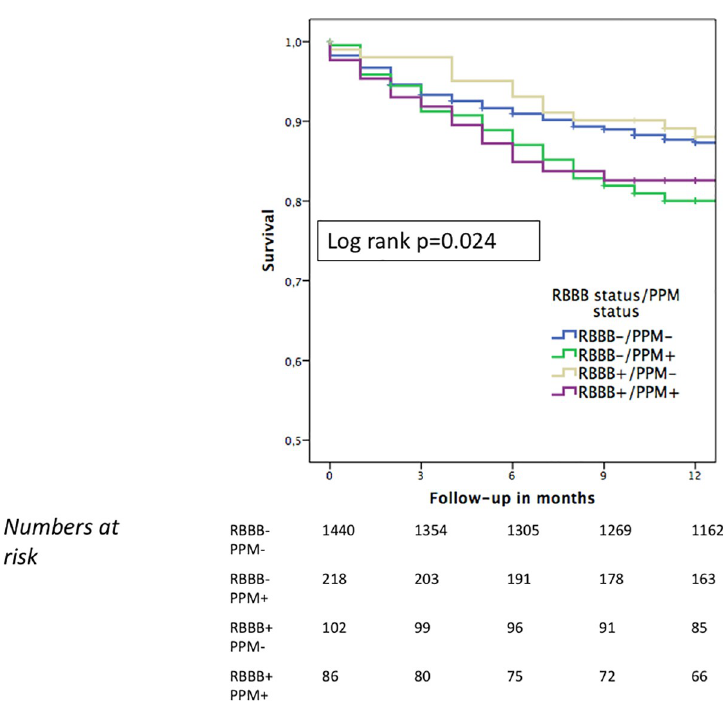
Fig 2. Kaplan-Meier estimates for one-year survival in RBBB versus non-RBBB patients stratified according to PPM implantation. During a follow-up time of 12 months, there was a significant difference in survival probability between the subgroups of RBBB and non-RBBB patients with either a new PPM or no new PPM: the worst outcome was observed for non-RBBB patients with new PPM. Abbreviations: RBBB = right bundle branch block; PPM = permanent pacemaker.